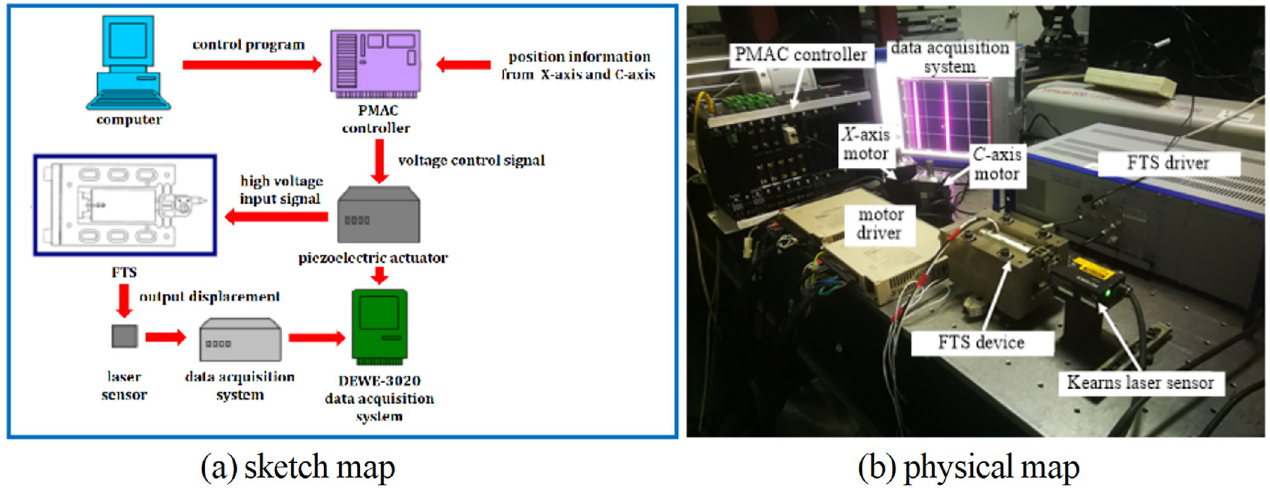
Fig 5. Offline simulation compensation machining